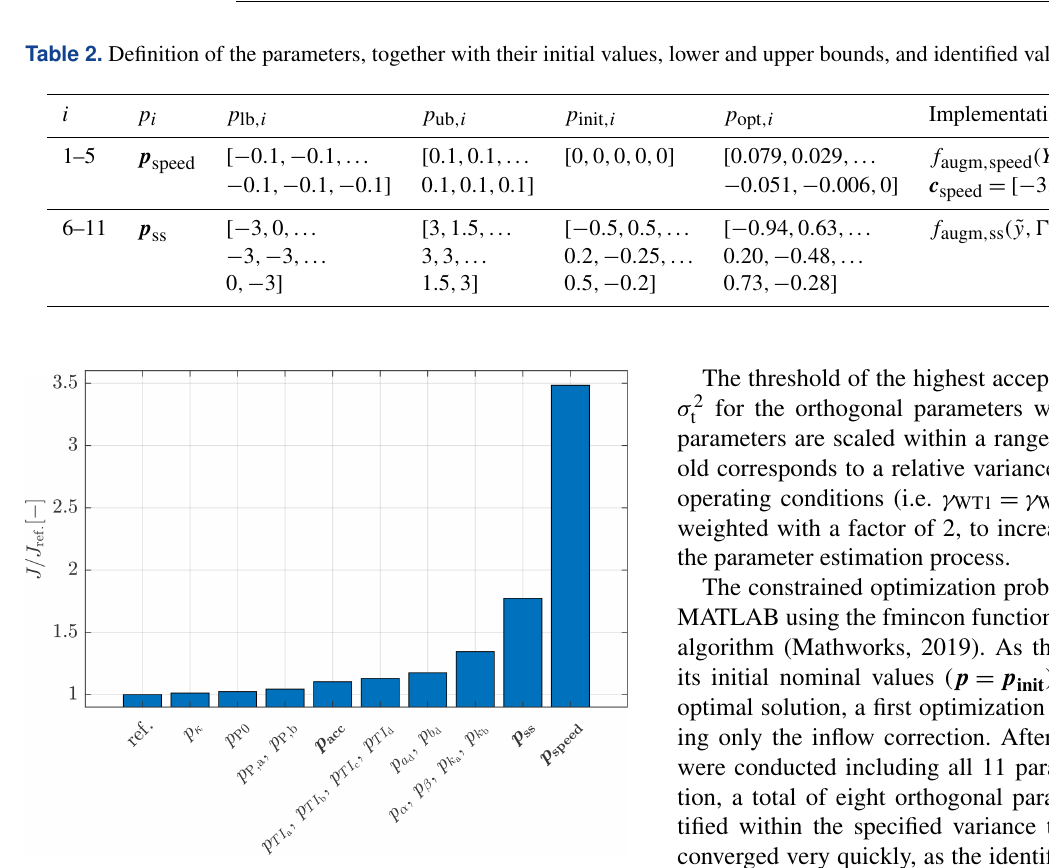
Figure 5. Relative increase in the optimization cost function when eliminating one parameter set at a